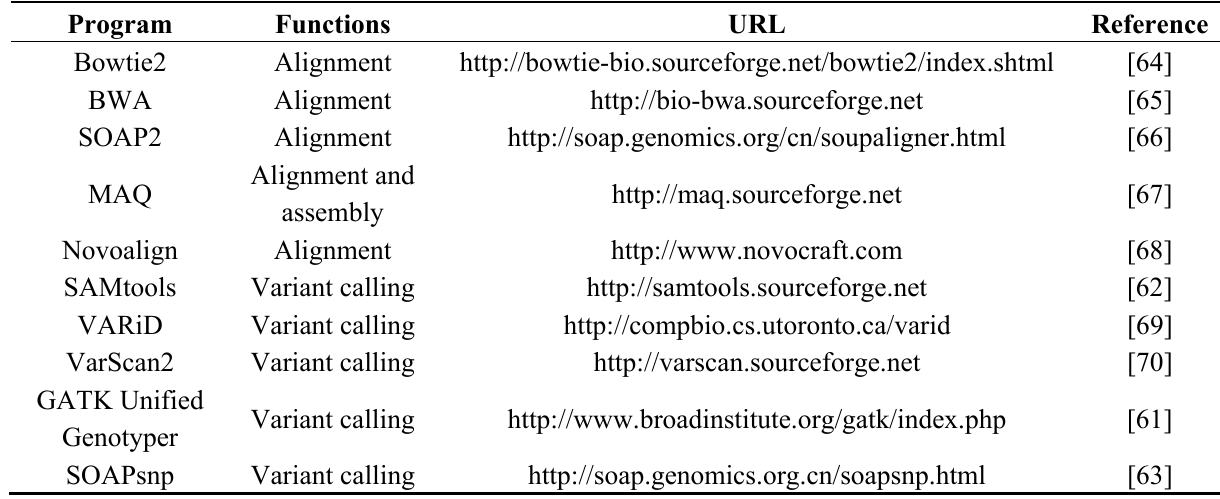
Table 3. Computational tools for MPS data analysis. Reproduced and modified with permission from